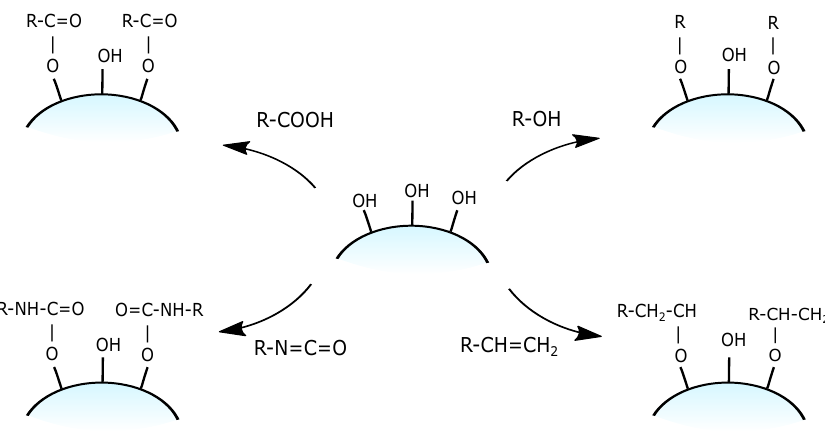
Figure 13. Grafting of silanol groups with simple organic